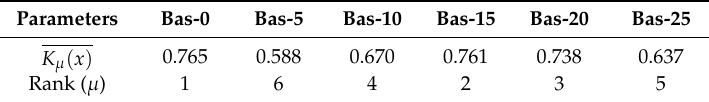
Table 5. Results of friction coe ffi cient by extension evaluation method.